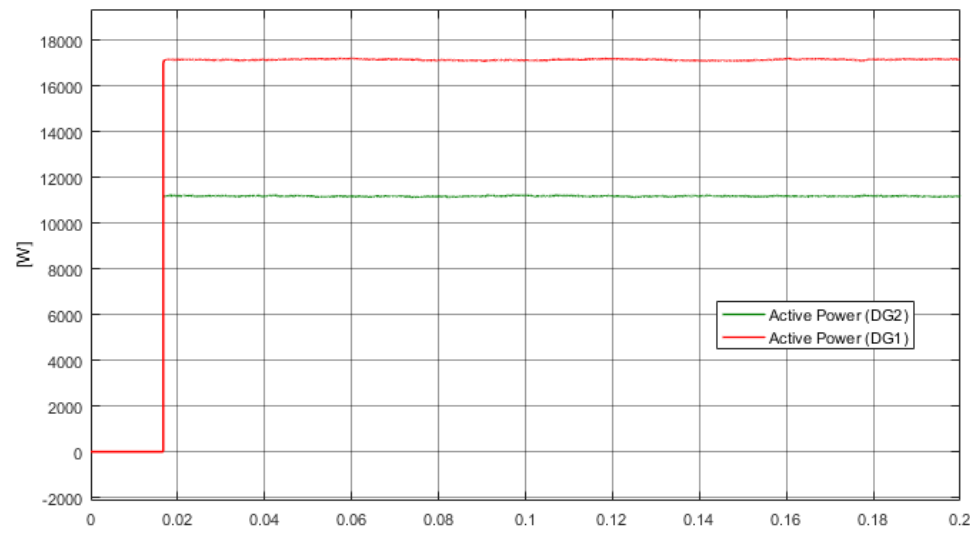
Figure 12. The waveform of output voltages and currents ( A , B ) of DG1 and ( C , D ) of DG2 in GC mode.